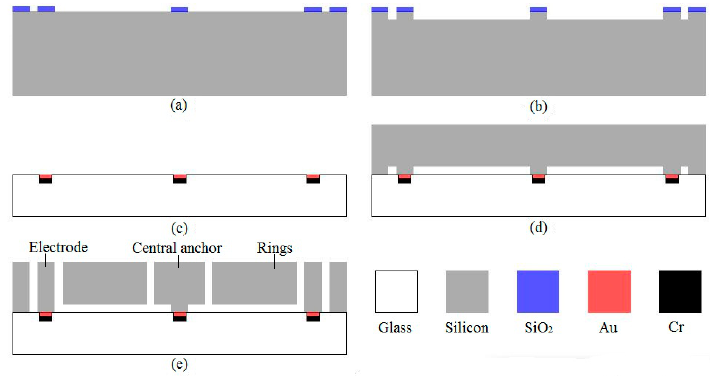
Figure 9. Main process flow of fabrication of DRG.